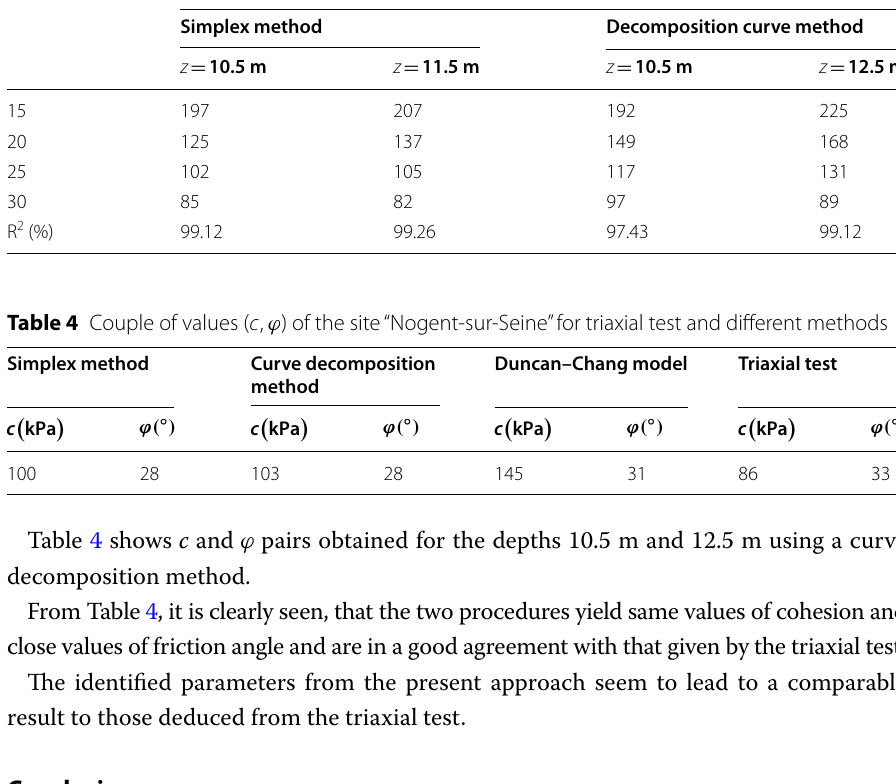
Table 3 Couples of values ( c , ϕ) for the site “Nogent-sur-Seine, France” φ (°) Cohesion c (cid:31) kPa (cid:30) Simplex method